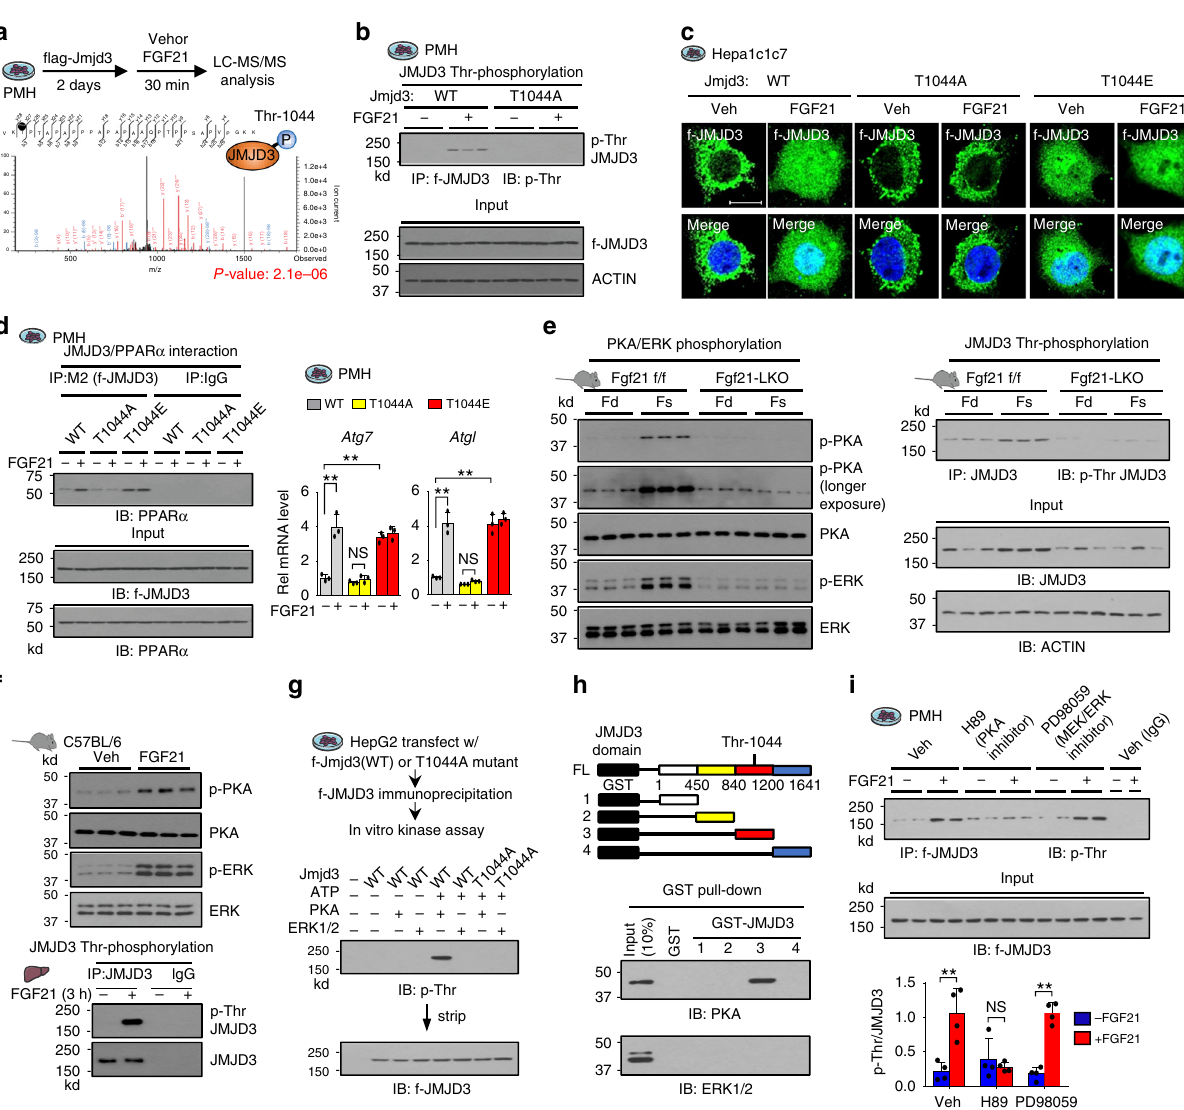
Fig. 6 Phosphorylation of JMJD3 by FGF21-activated PKA is critical for autophagy induction. a Experimental outline (top) and spectrum from LC-MS/ MS analysis identifying a JMJD3 peptide containing phosphorylated Thr-1044 (bottom). b PMH were transfected with plasmids as indicated, and after 48 h, were treated with vehicle or FGF21 (100 ng/ml) for 30 min. p-Thr-JMJD3 levels were detected by IP/IB and input protein by IB ( n = 3 culture dishes). c Hepa1c1c7 cells were transfected with JMJD3 expression plasmids and treated with vehicle or FGF21 for 30 min. Flag-JMJD3 (green) was detected by immuno fl uorescence (scale bar = 5 μ m). d PMH were transfected with JMJD3 expression plasmids as indicated and treated with vehicle or FGF21 for 30 min for CoIP (left) or 2 h for qRT-PCR (right). PPAR α in fl ag-JMJD3 immunoprecipitates or in input detected by IB (left) and the mRNA levels of the indicated genes (right, n = 3 culture dishes). e FGF21- fl oxed or -LKO mice were fasted for 24 h or refed for 24 h after fasting. Levels of proteins were detected by IB (left) and p-Thr JMJD3 were detected by IP/IB (right) ( n = 3 mice). f C57BL/6 mice were treated with 0.1 mg/kg FGF21 for 3 h and then, phosphorylated levels of PKA, ERK, and JMJD3 were detected by IB ( n = 3 mice). g Immunoprecipitated fl ag-JMJD3 was incubated with ATP, PKA, or ERK1/2 as indicated and levels of p-Thr-JMJD3 were detected by IB. h Schematic of fragments of JMJD3 that were fused to GST (top). Binding of PKA or ERK1/2 to GST-JMJD3 proteins was detected by IB (bottom). i PMH were treated with FGF21 and with vehicle or a PKA (H89,10 μ M) or MEK/ERK (PD98059, 40 μ M) inhibitor for 30 min. Levels of p-Thr-JMJD3 were detected by IP/IB (top) and quanti fi ed (bottom, n = 4 culture dishes). Source data are provided as a Source Data fi le. d , i Values are presented as mean ± SD. Statistical signi fi cance was measured using ( d , i ) two-way ANOVA with the Bonferroni post-test. ** P < 0.01, and NS statistically not signi fi